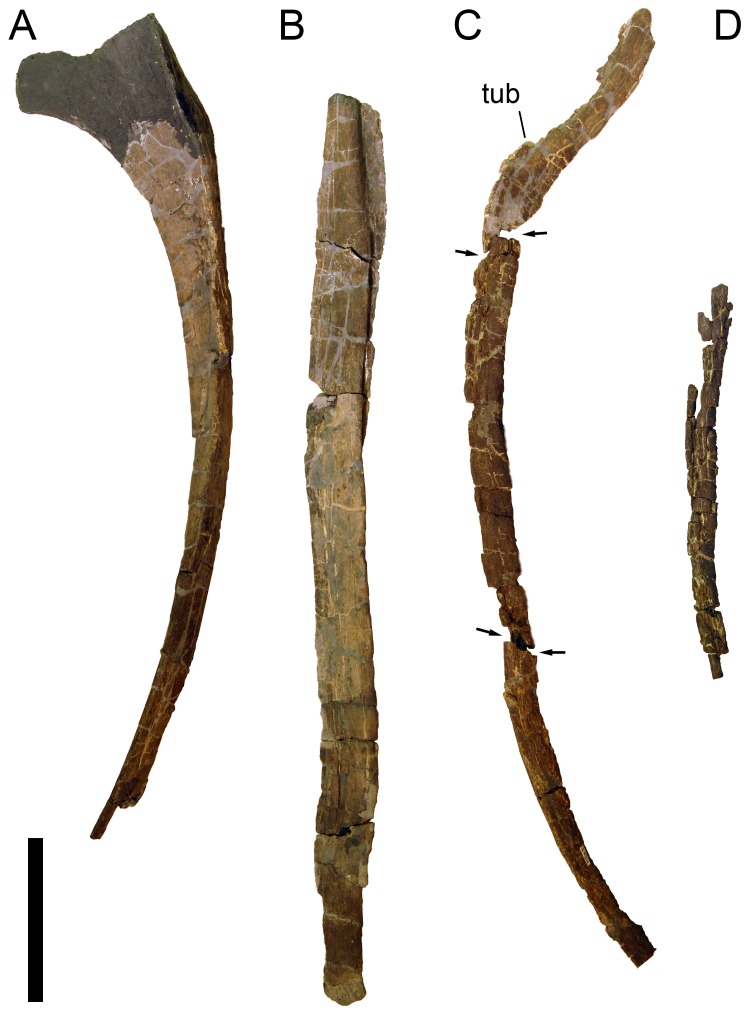
Posterior right dorsal ribs of Galeamopus pabsti SMA 0011.The ribs are estimated to be dorsal ribs 6 in posterior (A), 7 in lateral (B), 8 in anterior (C) and 9 in posterior (D), view. Rib head and distal tips of ribs 6, 7, and 9 are not preserved. The rib head of DR 6 is reconstructed. The rib 8 is preserved in three parts (fractures indicated by arrows). Abb.: tub, tuberculum. Scale bar = 20 cm.